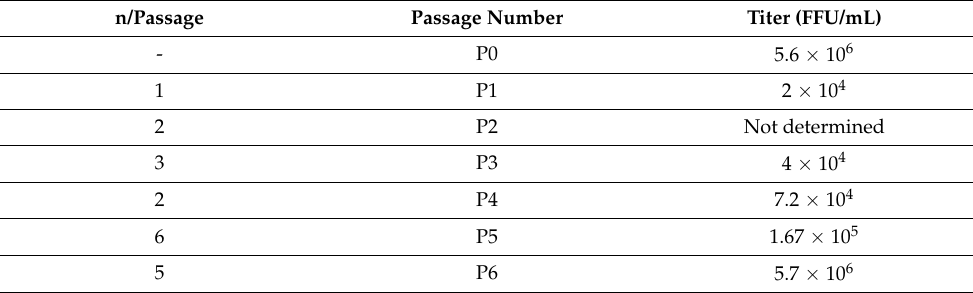
Figure 1. Arg HRV titers through passaging in neonatal Gn pigs. Data presented are log10 trans- formed area under the curve (AUC) of virus shedding in feces. Peak virus shedding occurred during passage 6. Table 1. Viral titers in intestinal contents collected after passaging. Small and large intestinal contents were collected from Gn pigs for each passage and were pooled. The viral titers were determined by CCIF. P0 refers to the initial titer of the infant stool sample before any passaging in pigs. n/Passage